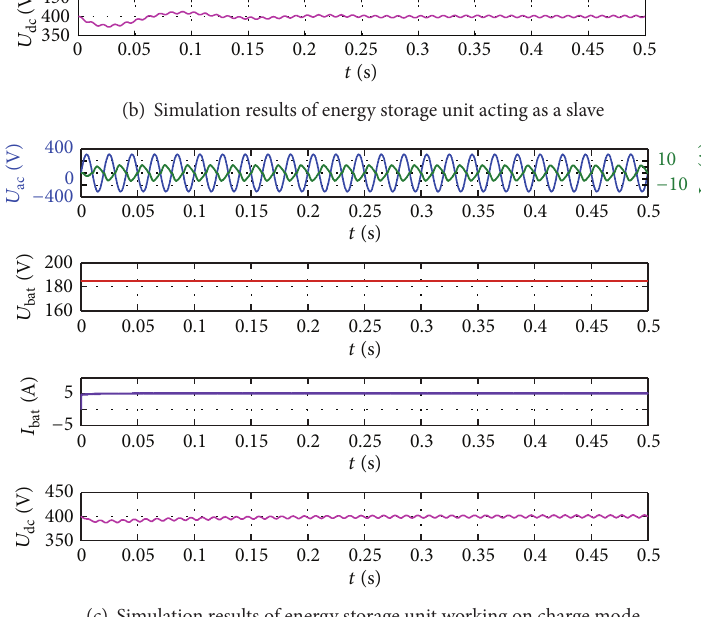
(c) Simulation results of energy storage unit working on charge mode Figure 12: Simulation results of the energy storage unit working on different